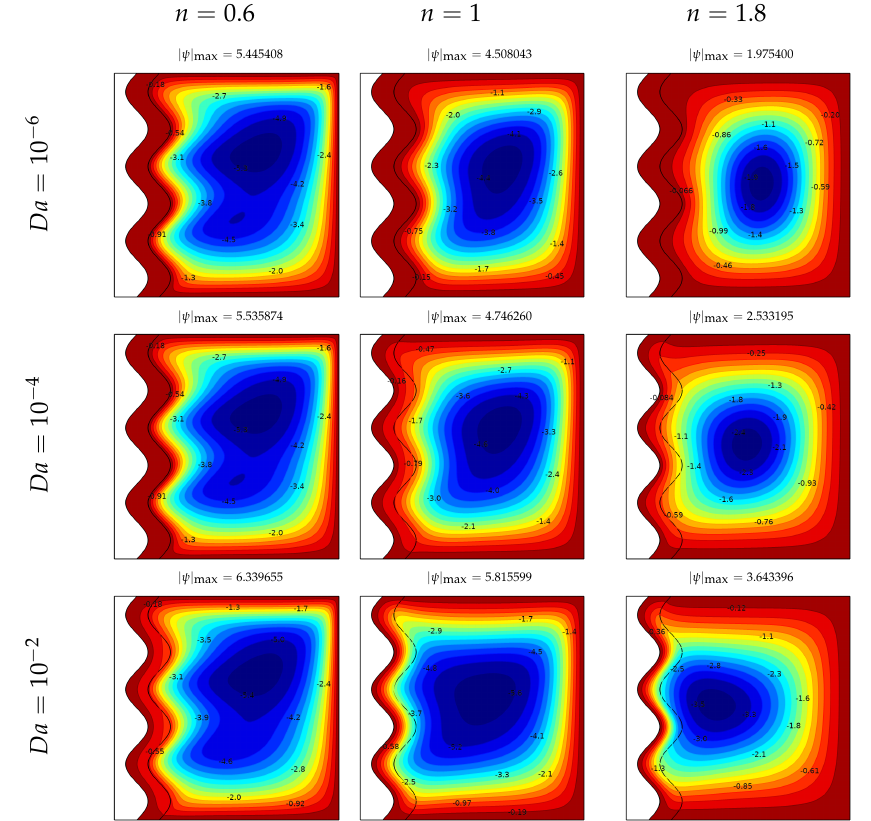
Figure 5. Streamlines for different values of power law indices n and Darcy numbers Da .